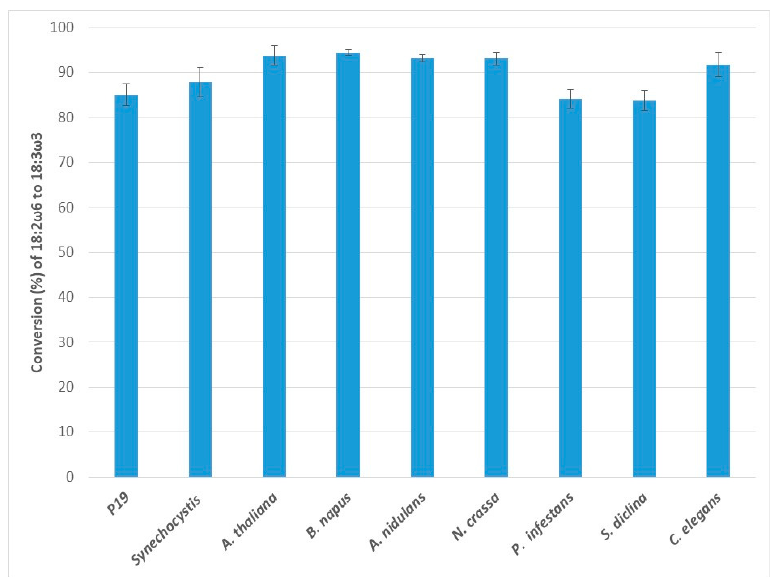
Figure 1. Enzymatic activities of transiently expressed ω 3Ds from various sources in N. benthamiana leaves on 18:2 ω 6 substrate. ω 3D activities were determined by measuring the conversion rate of endogenous 18:2 ω 6 substrate to 18:3 ω 3 in leaves expressing p19 silencing suppressor only as a control or the appropriate ω 3D with p19. The error bars denote the standard deviations of the means from triplicate assays.